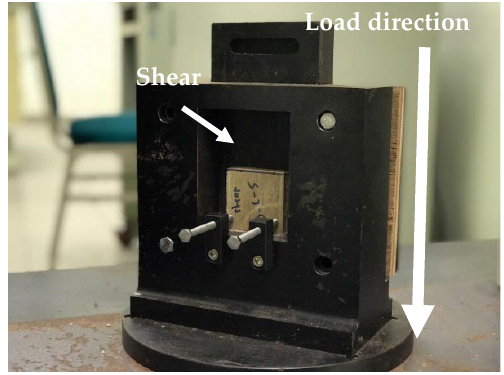
Figure 2. Load application with adjustable seat to provide a uniform distribution of load.